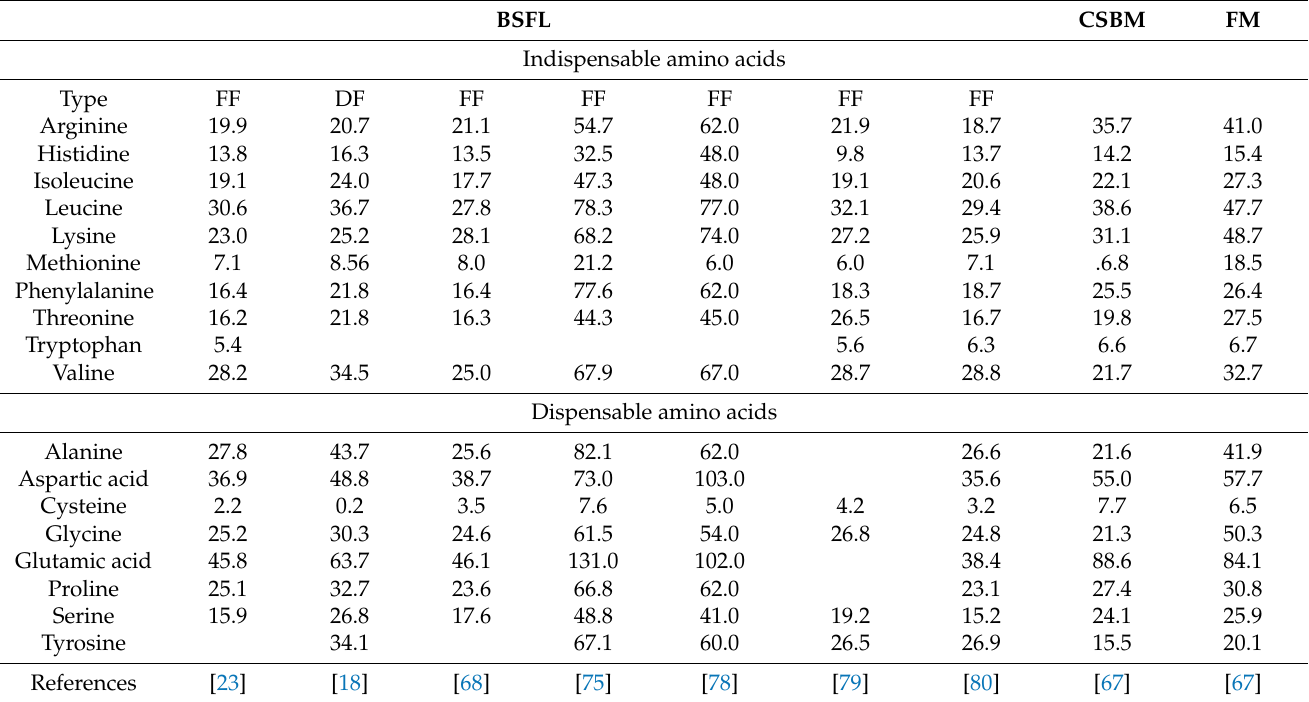
Table 2. Amino acid composition of BSFL (g kg − 1 dry matter